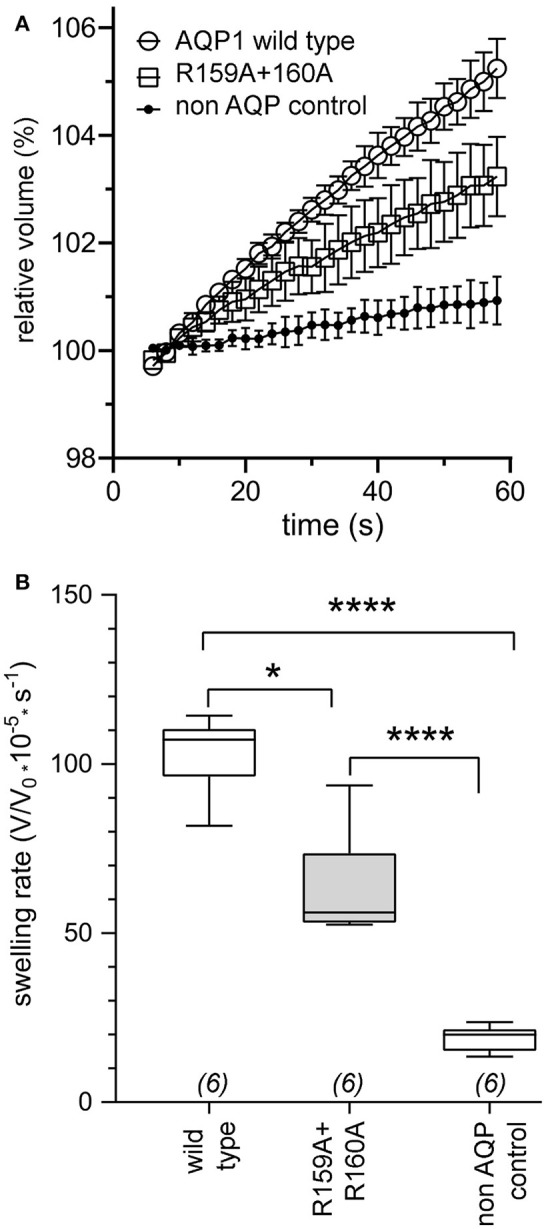
Confirmation of expression of AQP1 wild type and AQP1 R159A+R160 mutant channels in oocyte plasma membranes by significantly increased osmotic water permeabilities as compared to non-AQP1 expressing controls. (A) Osmotic water permeabilities (mean ± SEM) assessed by quantitative swelling assays for AQP1 wild type (open circles) and AQP1 R159A+R160 mutant (squares) compared with non-AQP1 expressing control oocytes (filled circles). Relative volumes as a function of time after introduction into 50% hypotonic saline at time zero were measured from video-imaged cross-sectional areas. (n = 6 per group). (B) Box plot data showing osmotic swelling rates were higher in oocytes expressing AQP1 wild type and AQP1 R159A+R160 mutants than non-AQP1 expressing controls (one way ANOVA; post-hoc Bonferroni tests). *p < 0.05; ****p < 0.0001; n = 6 per group. Boxes show 50% of data points; error bars show the full range; horizontal bars show median values.